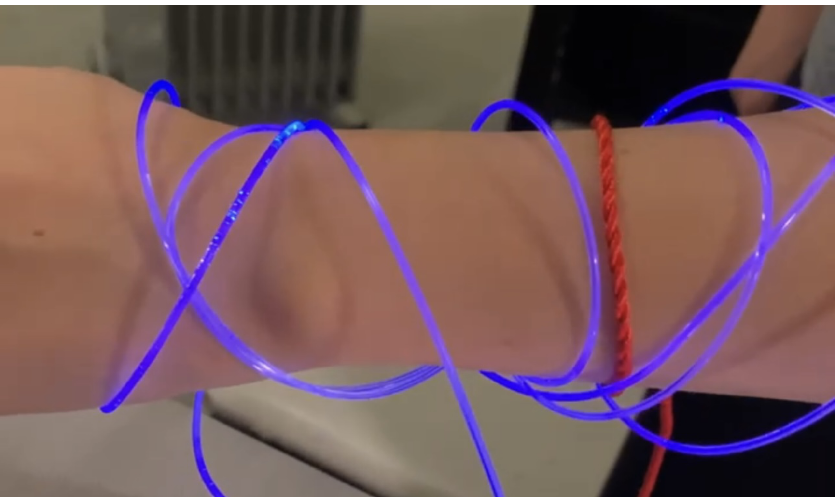
Figure 16. Early prototype, an